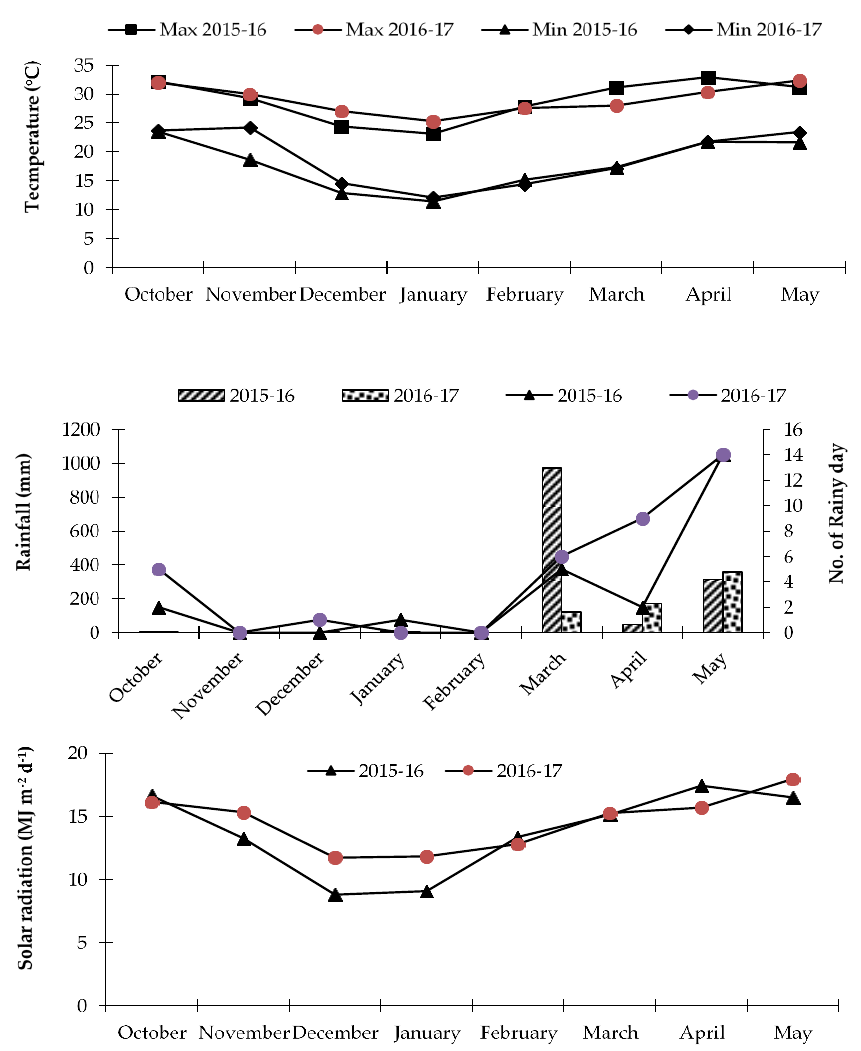
Figure 1. Monthly average of temperature, rainfall, and solar radiation for the two consecutive